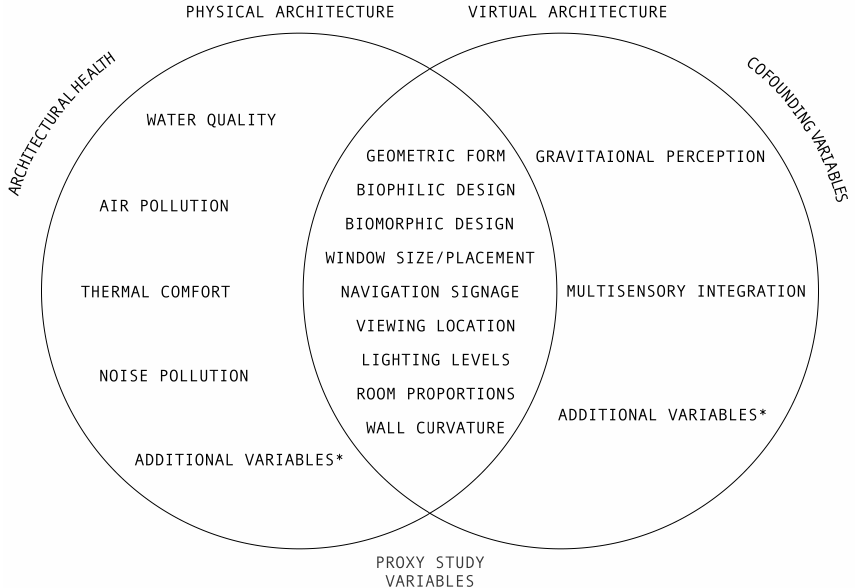
Figure 2. This Venn diagram illustrates the series of complex interactions between confounding variables in VA, proxy studies and PA health research. Left: variables (e.g., water quality and air pollution) that are directly relevant to occupant health and are inherent to PA. Centre: variables identified and assessed using proxy studies. These variables are relevant both to health concerns in PA (left) and in VA (as established by proxy studies). Right: confounding variables that may further exacerbate health concerns in VA (as identified in this paper). Both gravitational perception and multisensory integration are identified, however, additional variables are likely to exist. * Additional variables not considered by this